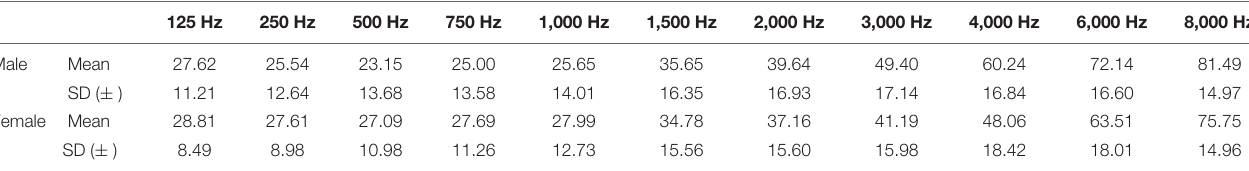
TABLE 3B | Mean (+ standard deviation) air-conduction thresholds (dB HL) in the better hearing ear in males and